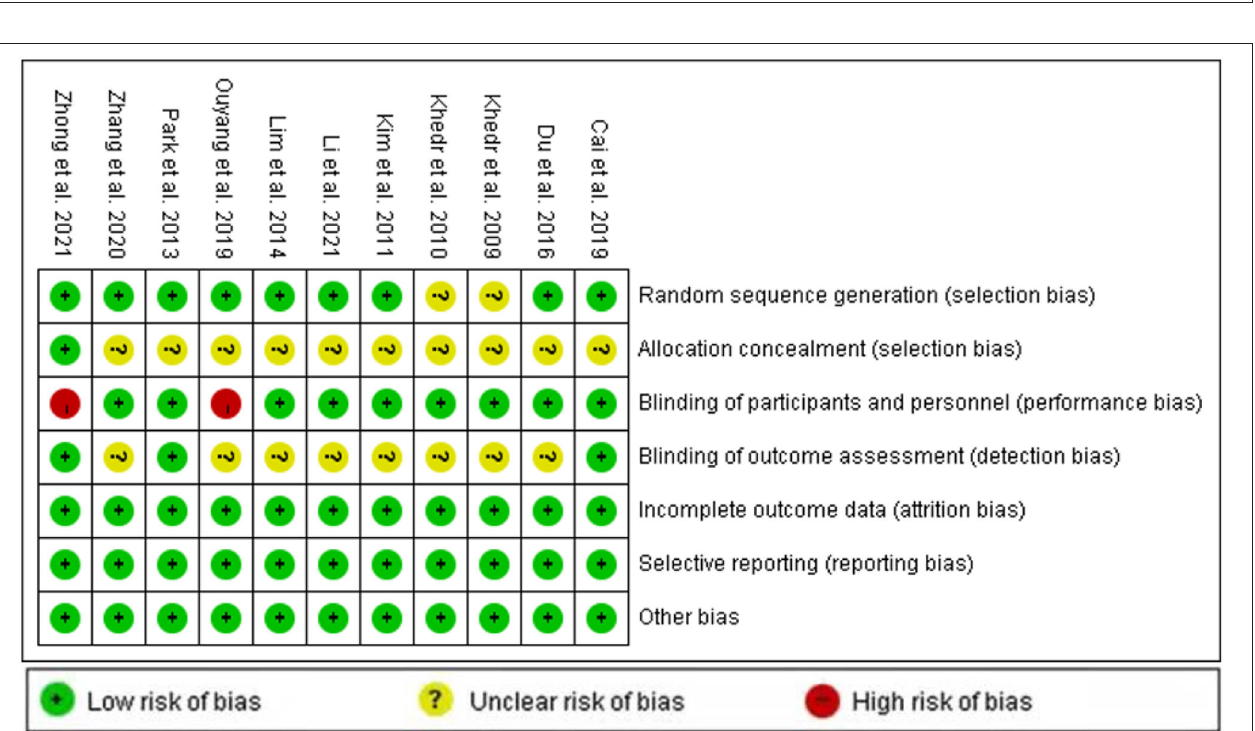
FIGURE 2 | Risk of bias items shown as percentages across the included RCTs.